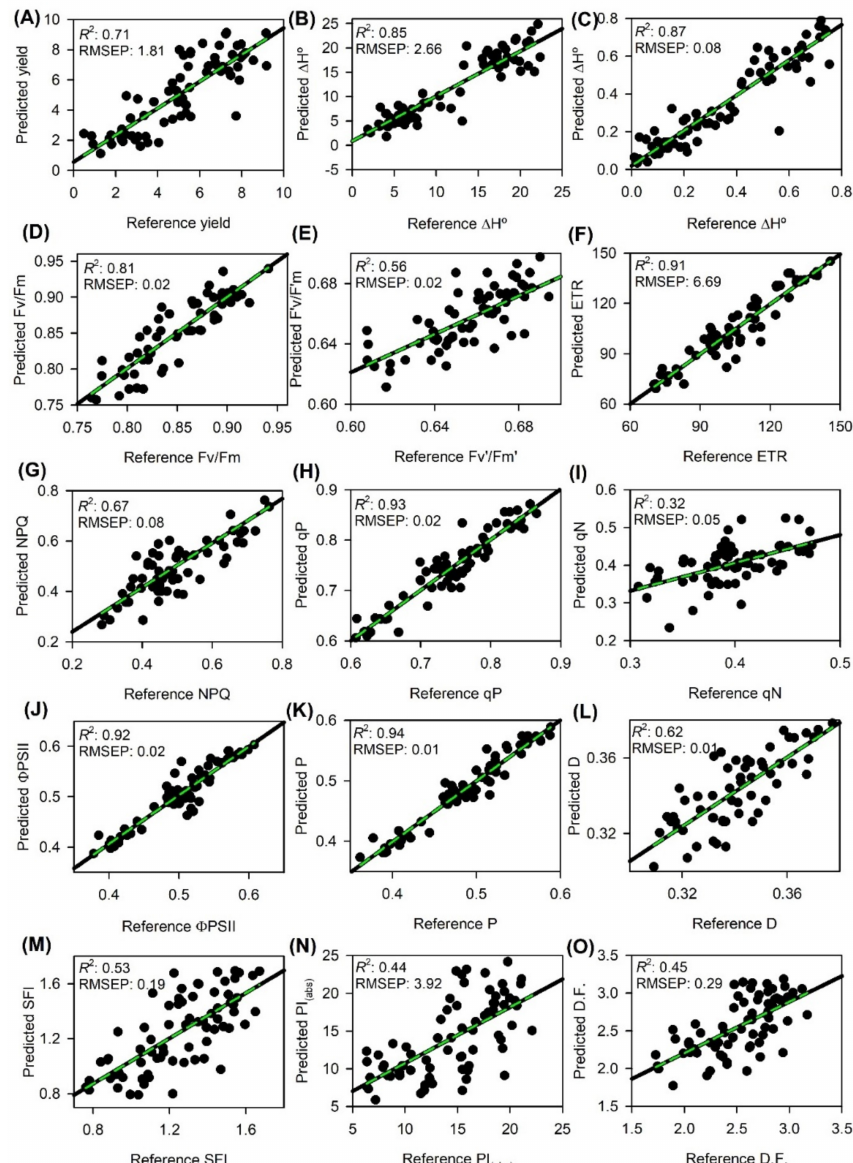
Figure 3. Reference vs. predicted data estimated by partial least squares regression (PLSR). Dotted (green) and solid (black) lines represent regression and 1:1, respectively. Model goodness-fit (R 2 ) and root mean square error predicted (RMSEP) for validation data generated using 70% of the data for calibration and 30% for validation are reported. Bias outputs are not shown, as they were always lower than 0.01. ( A ) Yield, biomass of tobacco plants (g plant − 1 ); ( B ) ∆ H ◦ mass (kcal g − 1 ), calorimeter energy content by mass; ( C ) ∆ H ◦ area (kcal m − 2 ), calorimeter energy content by